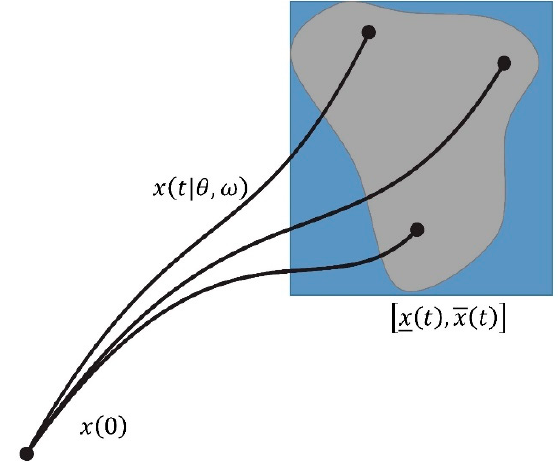
Figure 3. Interval prediction algorithm.